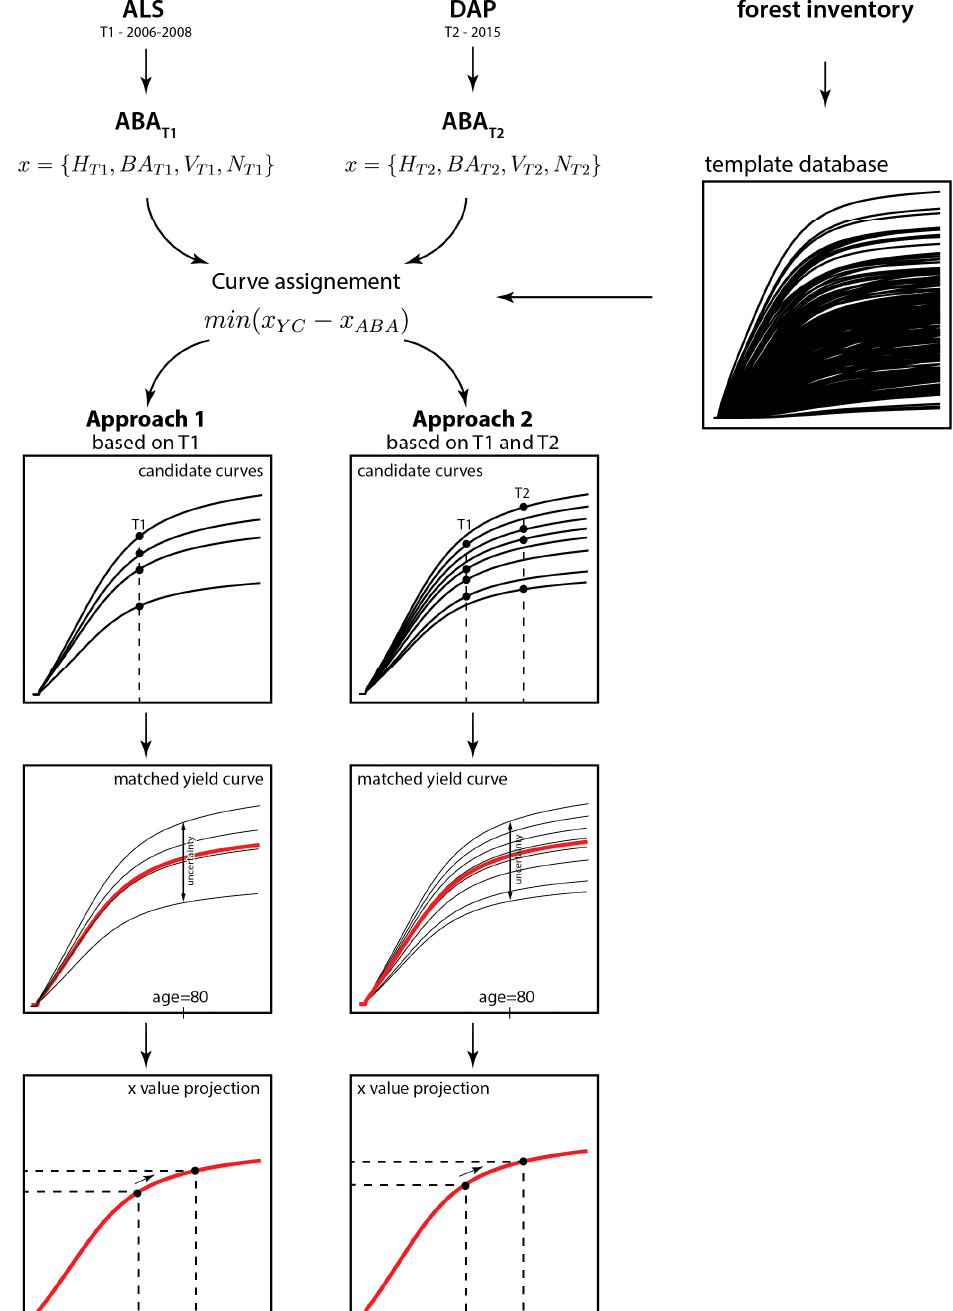
Figure 3. Overview of the processing steps followed. ABA—area-based approach, X YC —value of a stand attribute on the yield curve, X ABA —value of a stand attribute derived with ABA.